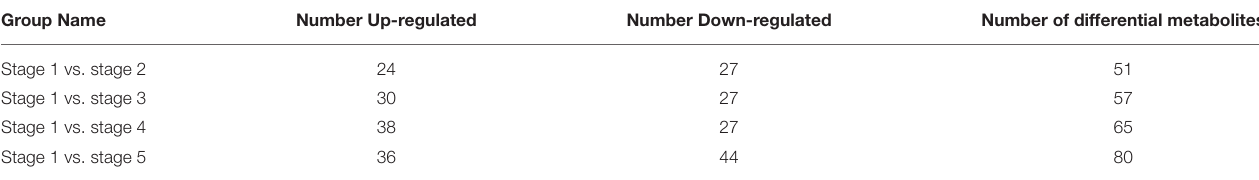
TABLE 1 | Summary of differentially accumulated metabolites (DAMs) between stage 1 and the other groups (stages 2–5).